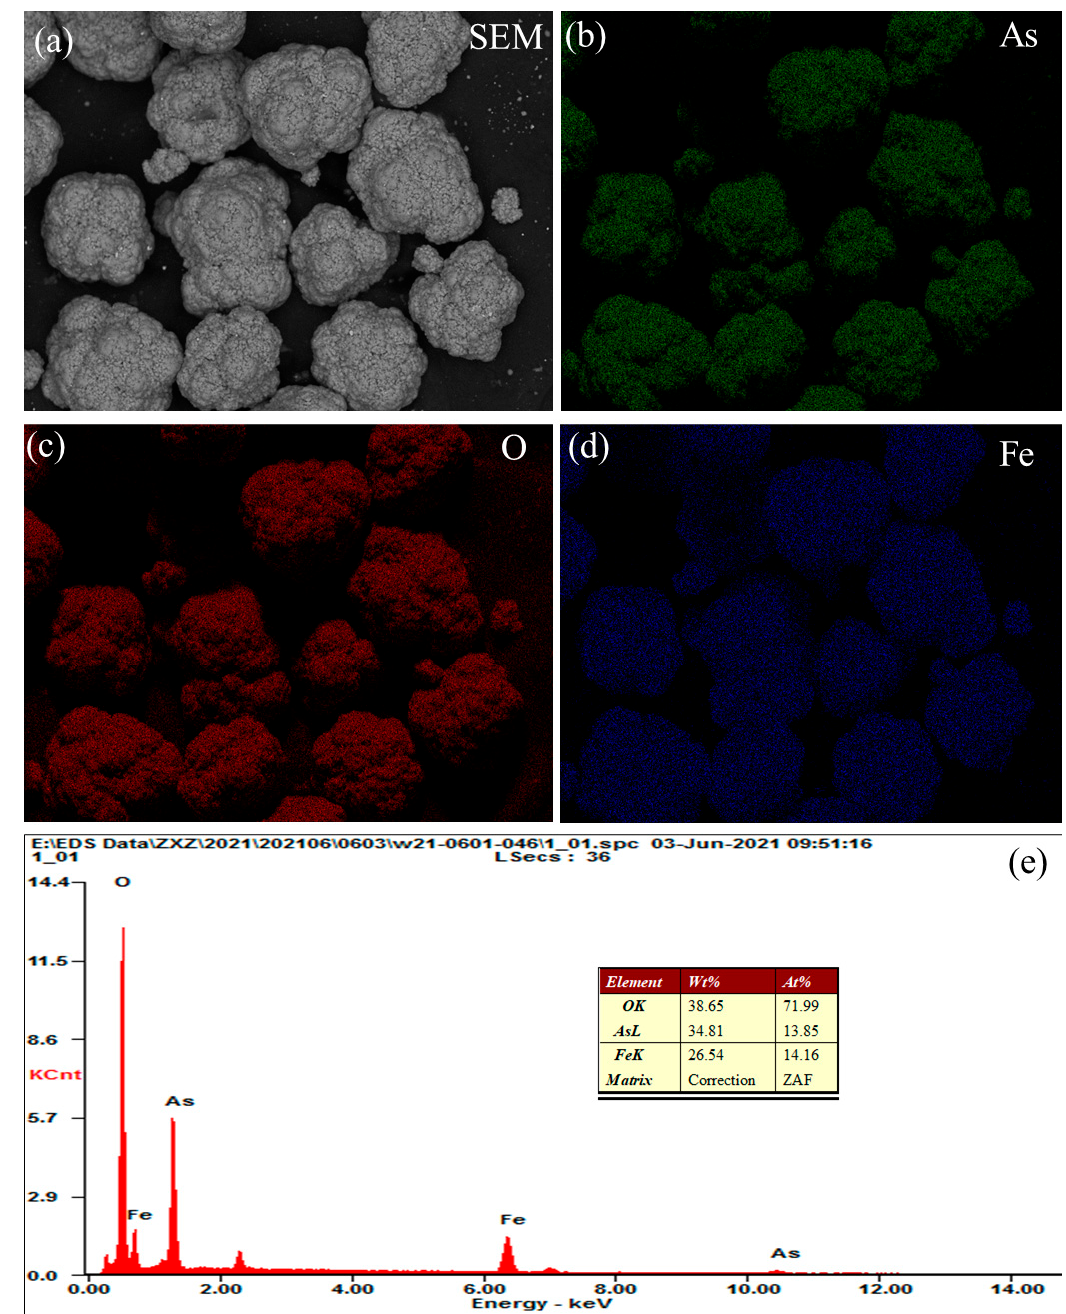
Figure 12. SEM–EDS analysis of the resulting product obtained under the optimum conditions. ( a ) SEM image of the resulting product, ( b ) As mapping, ( c ) O mapping, ( d ) Fe mapping, ( e ) EDS analysis of the resulting product; OK: oxygen, AsL: arsenic, FeK: iron, ZAF: a quantitative correction technique and Z means atomic number, A means absorption coefficient, F means fluorescence coefficient.